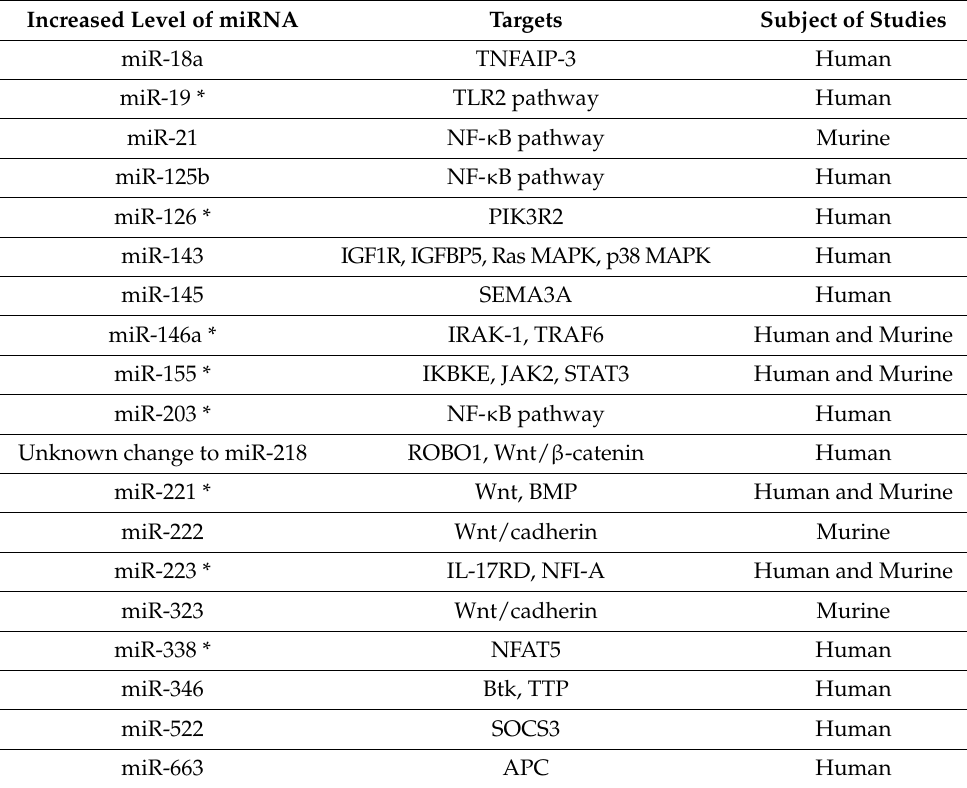
Table 3. List of increased levels of miRNA in RASFs with their targeted genes [8]. Increased Level of miRNA